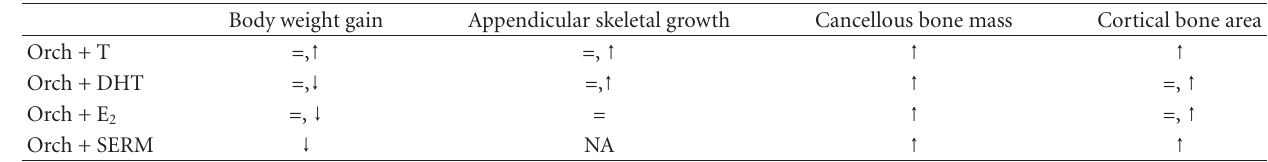
Table 3: Relative e ff ects of testosterone, dihydrotestosterone, estradiol, and selective estrogen receptor modulator on body weight, appendicular skeletal growth, cancellous bone mass, and on cortical bone